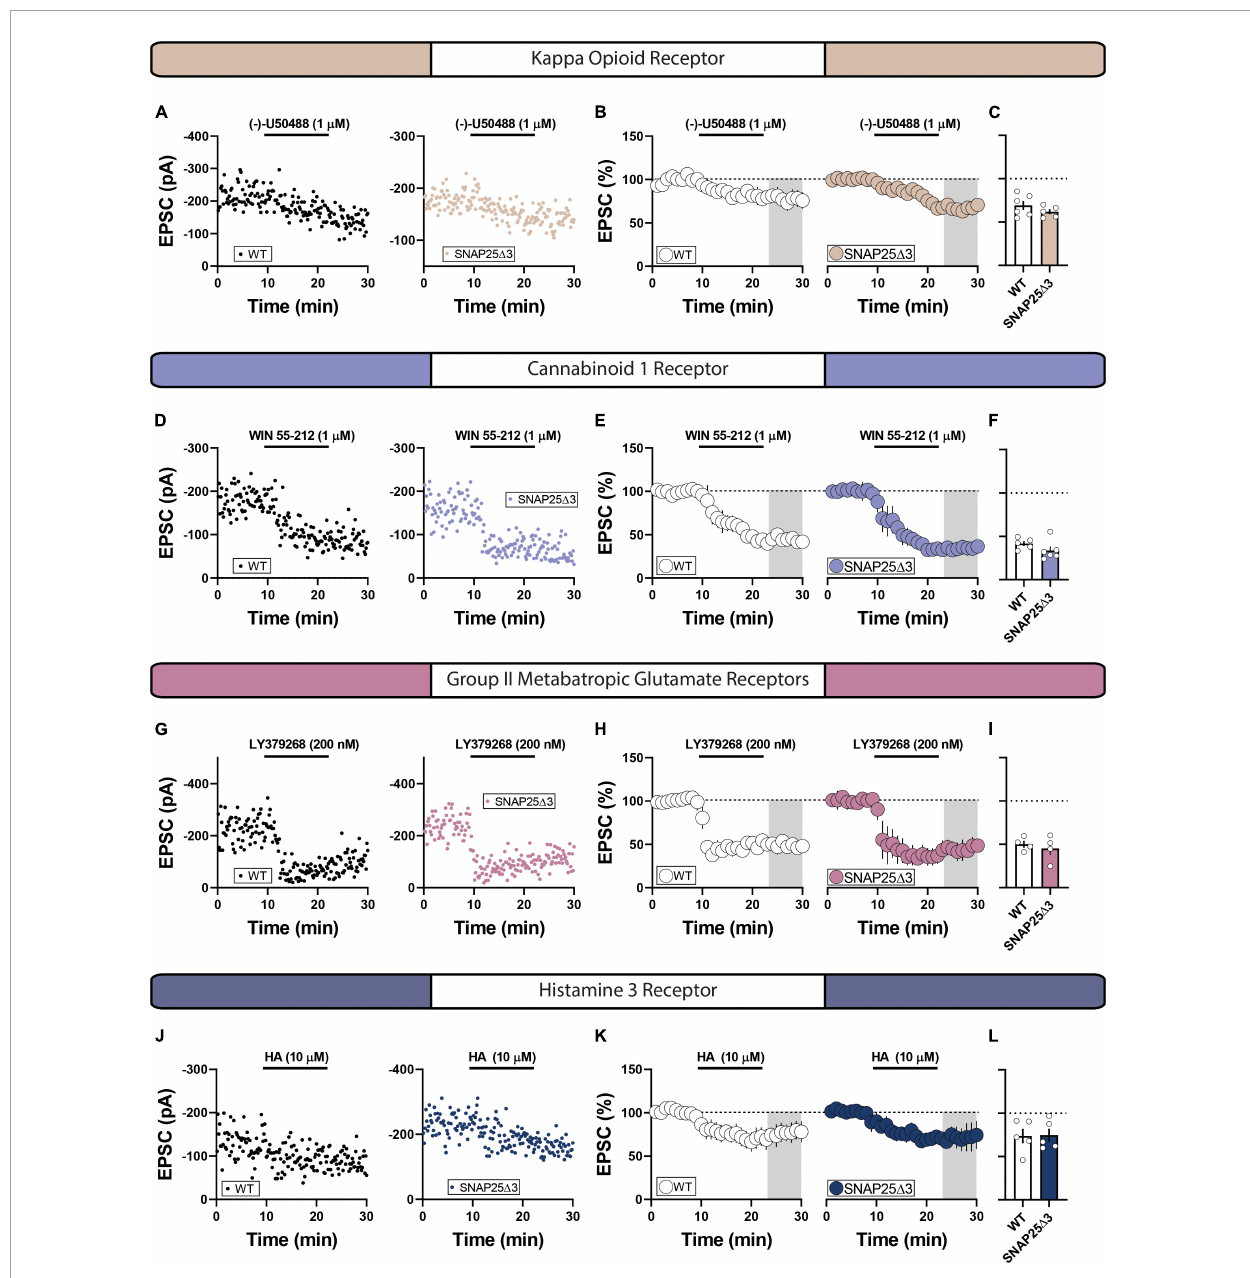
FIGURE3 Not all tested G i / o -coupled GPCR systems were affected by SNAP25 (cid:49) 3. (A) Representative experiments showcasing amplitude peaks of EPSCs following bath application of κ opioid receptor agonist (-)-U50488 (final concentration = 1 uM) collected from WT and SNAP25 (cid:49) 3 mice. (B) Percentage changes in EPSC peak amplitude with regards to baseline following (-)-U50488 application (application time: 10–20 min). (C) Summary of average EPSC percentages following (-)-U50488 application (time = 25–30 min; WT: mean = 65.89 ± 4.80%; SNAP25 (cid:49) 3: mean = 65.74 ± 4.60%; p = 0.9824). [WT: n = 5 cells, N = 3 animals; SNAP25 (cid:49) 3: n = 6 cells]. (D) Representative experiments showcasing amplitude peaks of EPSCs following bath application of cannabinoid 1 receptor agonist WIN 55–212 (final concentration = 1 uM) collected from WT and SNAP25 (cid:49) 3 mice. (E) Percentage changes in EPSC peak amplitude with regards to baseline following WIN 55–212 application (application time: 10–20 min). (F) Summary of average EPSC percentages following WIN 55–212 application (time = 25–30 min; WT: mean 41.67 ± 2.78%; SNAP25 (cid:49) 3: mean = 33.62 ± 4.57%; p = 0.1876). [WT: n = 5 cells; SNAP25 (cid:49) 3: n = 6 cells. (G) Representative experiments showcasing amplitude peaks of EPSCs following bath application of group II metabotropic glutamate receptor agonist LY379268 (final concentration = 1 uM) collected from WT and SNAP25 (cid:49) 3 mice. (H) Percentage changes in EPSC peak amplitude with regards to baseline following LY379268 application (application time: 10–20 min). (I) Summary of average EPSC percentages following LY379268 application (time = 25–30 min; WT: mean 50.08 ± 3.95%; SNAP25 (cid:49) 3: mean = 45.29 ± 7.56%; p = 0.5942). [WT: n = 4 cells; SNAP25 (cid:49) 3: n = 4 cells]. (J) Representative experiments showcasing amplitude peaks of EPSCs following bath application histamine 3 receptor agonist histamine (HA final concentration = 10 uM) collected from WT and SNAP25 (cid:49) 3 mice. (K) Percentage changes in EPSC peak amplitude with regards to baseline following HA application (application time: 10–20 min). (L) Summary of average EPSC percentages following HA application (time = 25–30 min; (WT: mean = 73.61 ± 8.36%; SNAP25 (cid:49) 3: mean = 74.69 ± 7.38%; p = 0.9252). [WT: n = 5 cells; SNAP25 (cid:49) 3: n = 5 cells]. Gray box indicates 5-min bin for comparative analysis. Error bars indicate SEM. Student’s unpaired, two-tailed, t